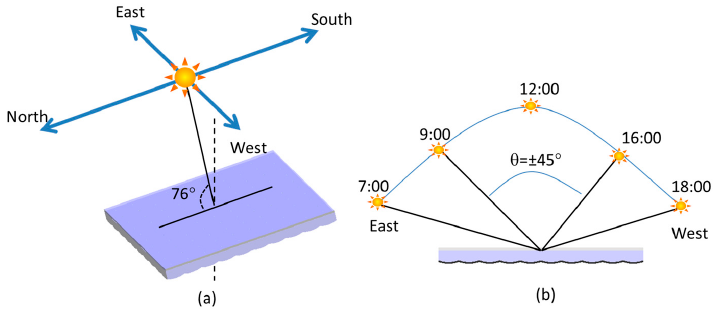
Figure 8. ( a ) Alignment of the system along the N–S and E–W directions; ( b ) Sun position at the different time of a day.